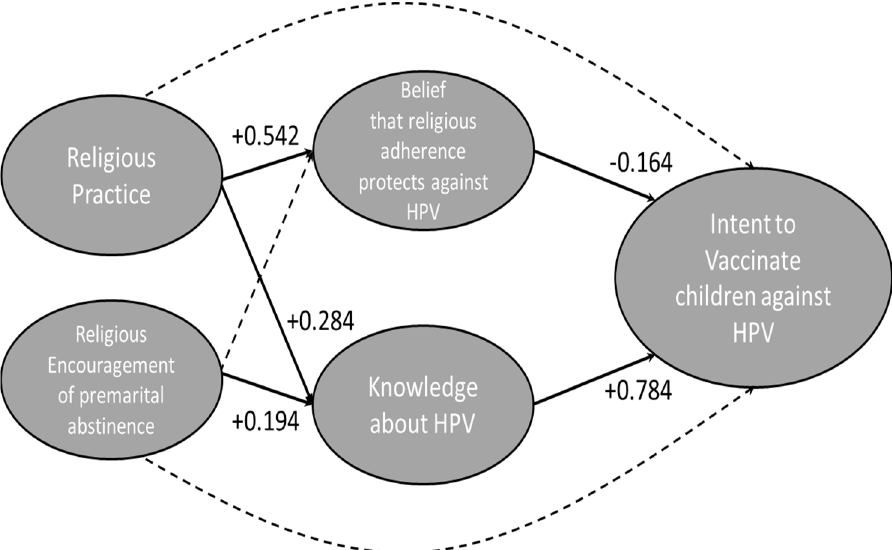
Figure 3. Structural Equation modeling results. Model B, representing the second component of our hypothesis. We hypothesize that religious practice and religious encouragement of premarital abstinence affects the belief that religious adherence protects against HPV and knowledge about HPV, which, in turn, both affect intent to vaccinate against HPV. Bolded lines indicate that a relationship is significant; the numbers adjacent to the lines indicate the strength and direction of the relationship.